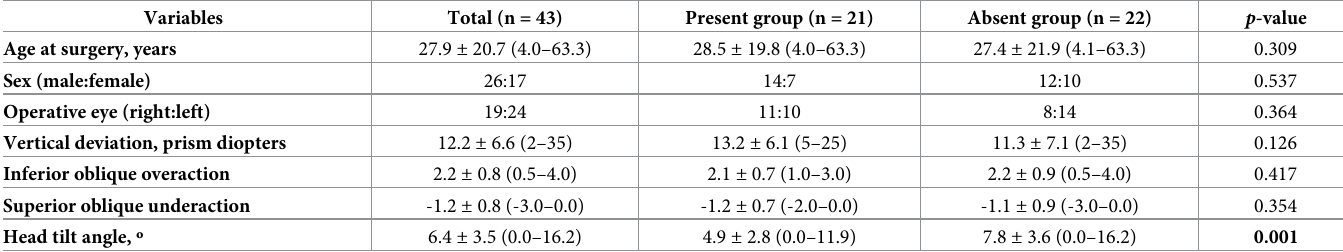
Table 1. Baseline demographic and preoperative data of the study population.